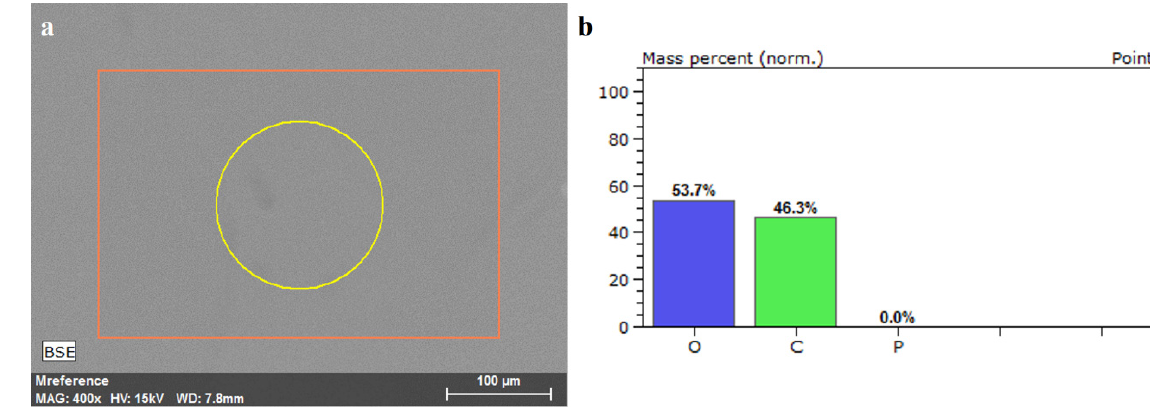
Figure 6. ( a ) SEM analysis and ( b ) EDX analysis of sample PE0.